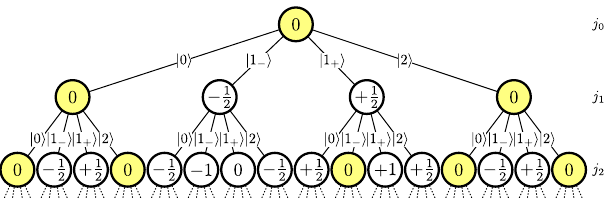
FIG. 10. The first three levels of the quaternary perfect tree representing the basis states. The vertices represent the color- electric flux indicated by the fermionic states on the edges along the path to each vertex using Eq. (6). The yellow filled circles represent those vertices, for which one encounters for the first time a negative value, if the path leading to the vertex is continued along the edge carrying j 1 − i